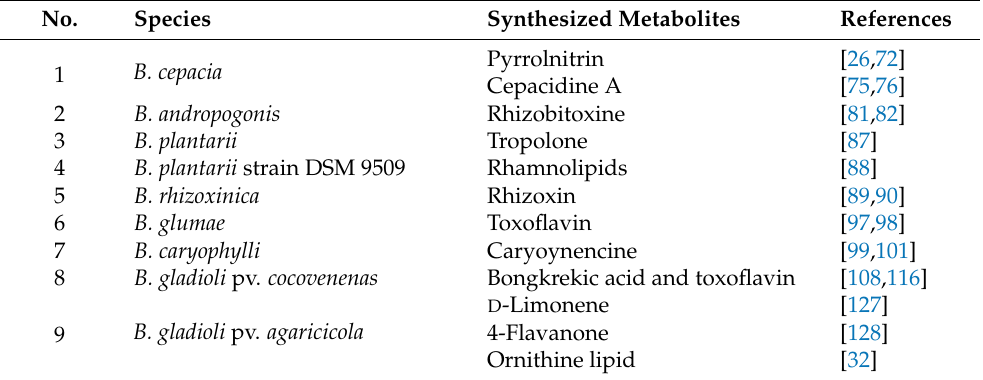
Table 2. List of secondary metabolites synthesized by some species of Burkholderia